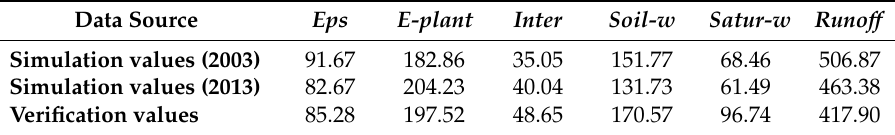
Table 6. Simulation and verification values. Unit: mm.